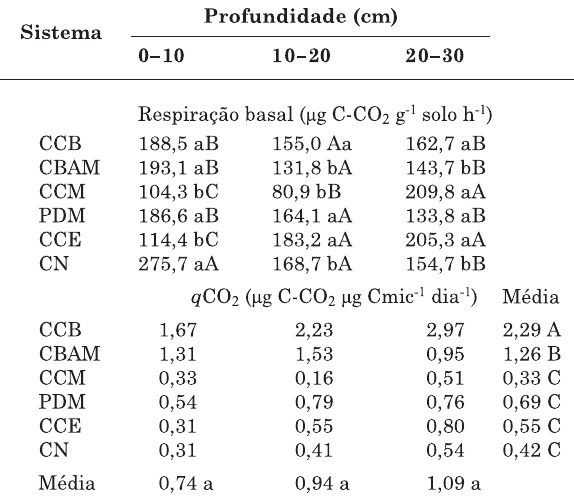
CCB: cultivo convencional com batata; CBAM: cultivo conven- cional com batata, sucedido por aveia e rotacionado com milho; CCM: cultivo convencional com milho; PDM: plantio direto com milho; CCE: cultivo convencional com eucalipto; CN: Cerrado nativo. Médias seguidas pela mesma letra, maiúscula na colu- na e minúscula na linha, não diferem entre si pelo teste de Scott-Knott a 5